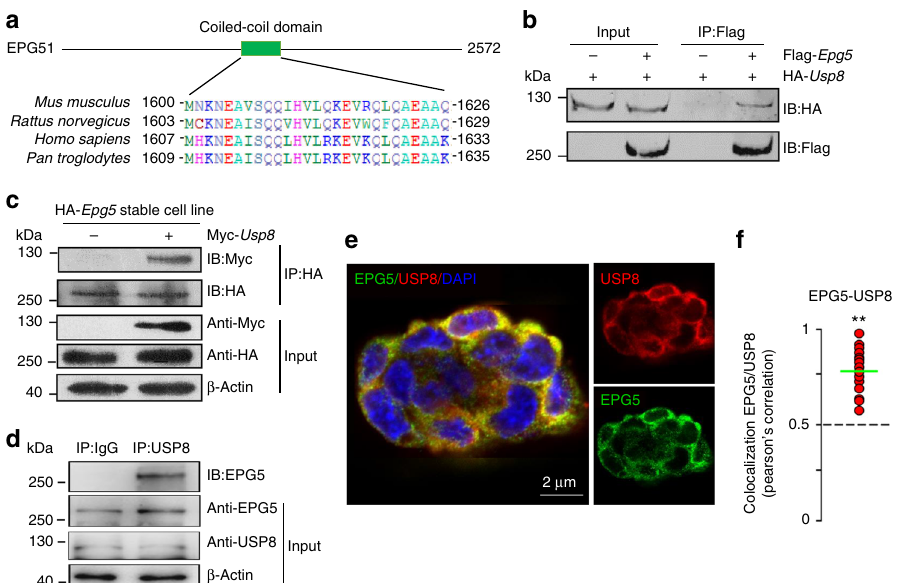
Fig. 3 EPG5 directly interacts with USP8 through its coiled-coil motif. a Sequence alignment of the EPG5 coiled-coil domain in mouse, rat, human, and chimpanzee. b USP8 interacts with EPG5 in HEK293T cells transfected with HA-USP8 and/or Flag-EPG5. c EPG5 interacts with USP8 in stable ESC lines harboring HA-EPG5 and/or Myc-USP8 vectors. d Endogenous EPG5 is coimmunoprecipitated with USP8 in ESCS. e Confocal fl uorescence microscopy images showing that endogenous EPG5 (green) co-localizes with USP8 (red) in ESCs. DAPI (blue). f Pearson ’ s correlation illustrated EPG5-USP8 colocalization. Red plots show colocalization values for individual cells, for >20 cells per condition. In all cases, similar results were seen in three independent experiments. Scale bars: 2 μ m. ** P < 0.01 by unpaired two-tailed Student ’ s t test in